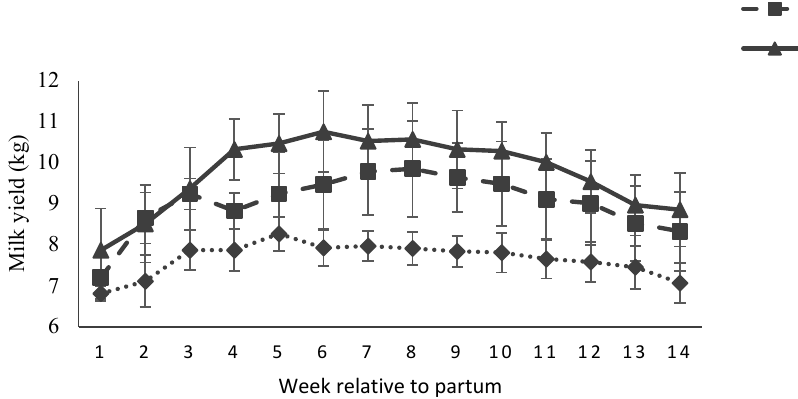
Figure 2. Milk yield (kg/d) of Nili Ravi buffaloes fed a low energy (LE), medium energy (ME) or high energy (HE) level during 9 weeks prepartum. Low, medium, and high energy levels were NE L : 1.30, 1.42, and 1.53 Mcal/kg, respectively, on DM basis in dietary treatments. Values represent LS means ±